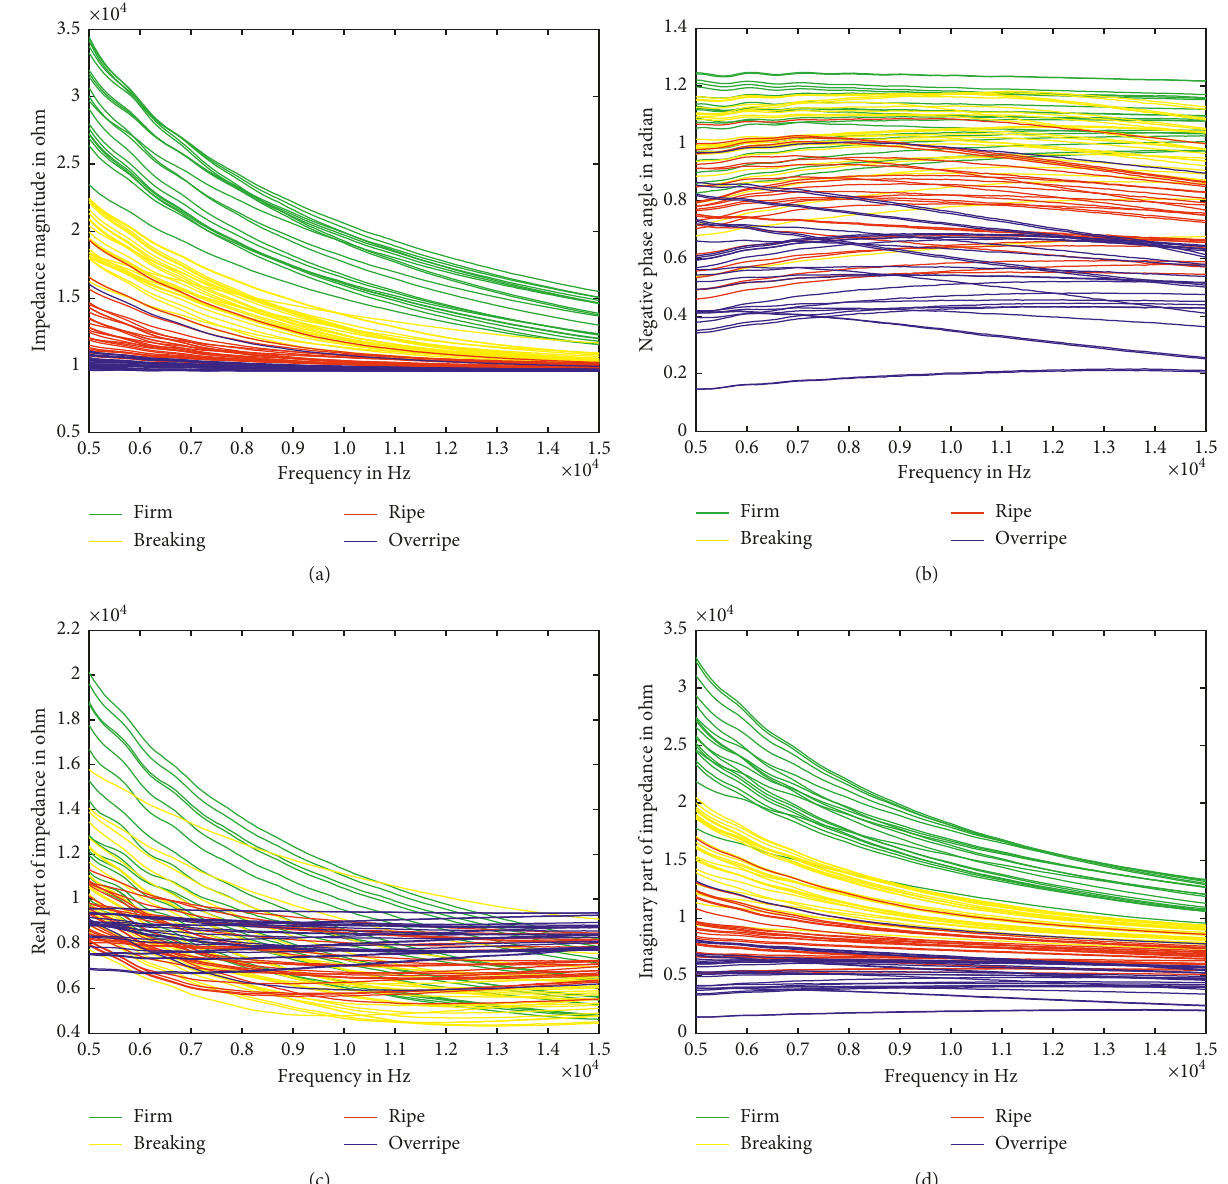
Figure 4: EIS response of all experimental avocado samples during ripening: (a) impedance magnitude vs. frequency, (b) negative phase angle vs. frequency, (c) real part of impedance vs. frequency, and (d) imaginary part of impedance vs.